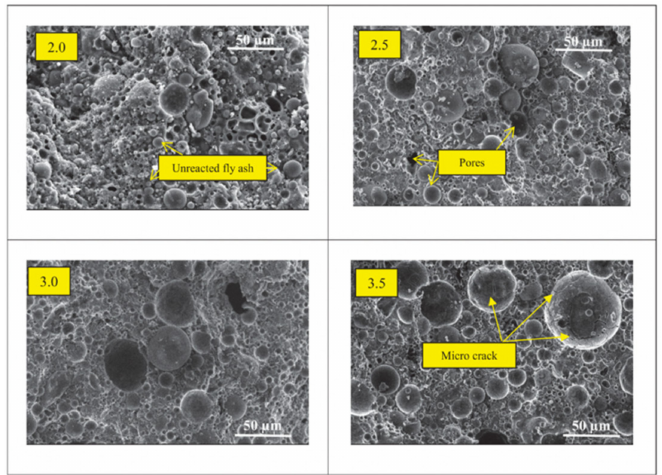
Figure 5. SEM of geopolymer aggregate at solid/liquid ratio of 2.0, 2.5, 3.0, and 3.5 [76].